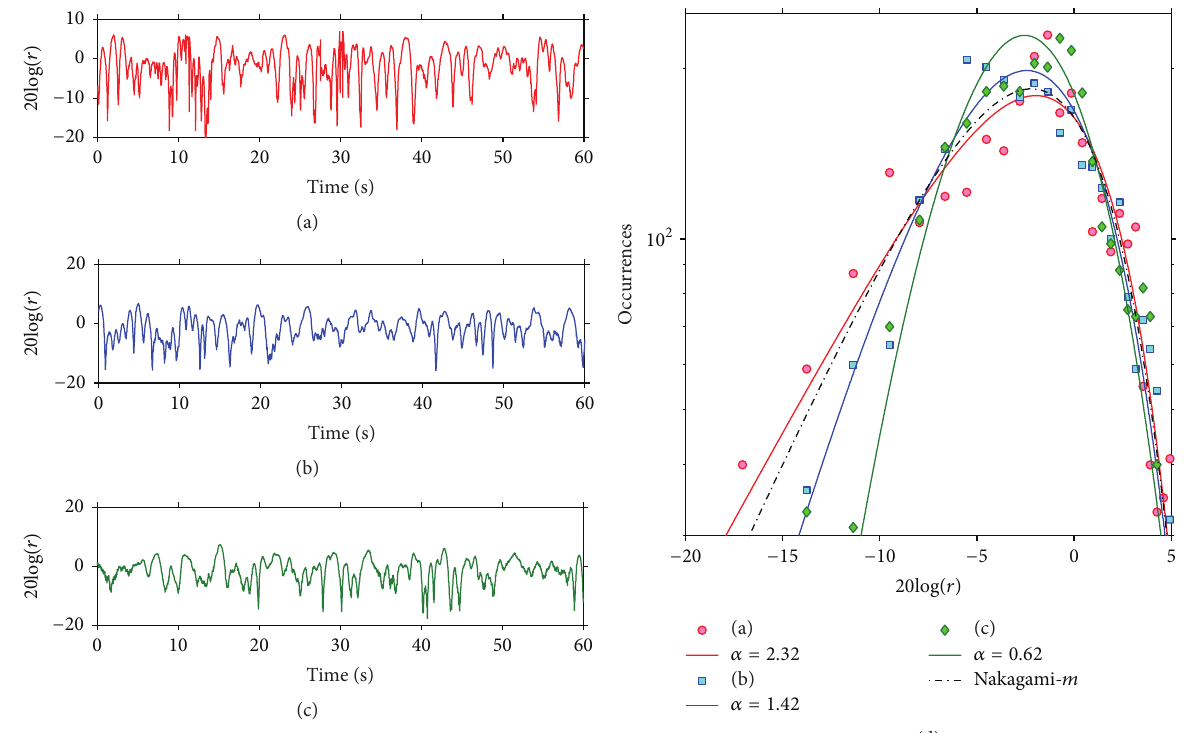
Figure 3: ((a), (b), and (c)) Three cases illustrating different scintillation patterns with approximately the same scintillation index 𝑆 4 ( ≈ 0.90). (d) Corresponding measured and calculated 𝛼 - 𝜇 distributions with parameters estimated with basis on (9), as well as the Nakagami- 𝑚 distribution with 𝑚 = 1/0.9 2 = 1.23